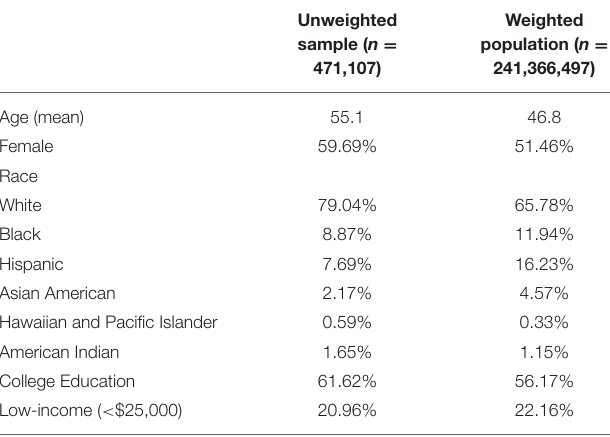
TABLE 1 | Sociodemographic characteristics of the sample (unweighted) and the population (weighted), US adults, Behavioral Risk Factor Surveillance System (BRFSS),